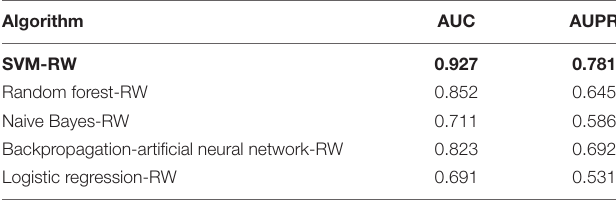
FIGURE 2 | ROC curve of SVM-RW. ROC, receiver–operator characteristic; SVM-RW, support vector machine and random